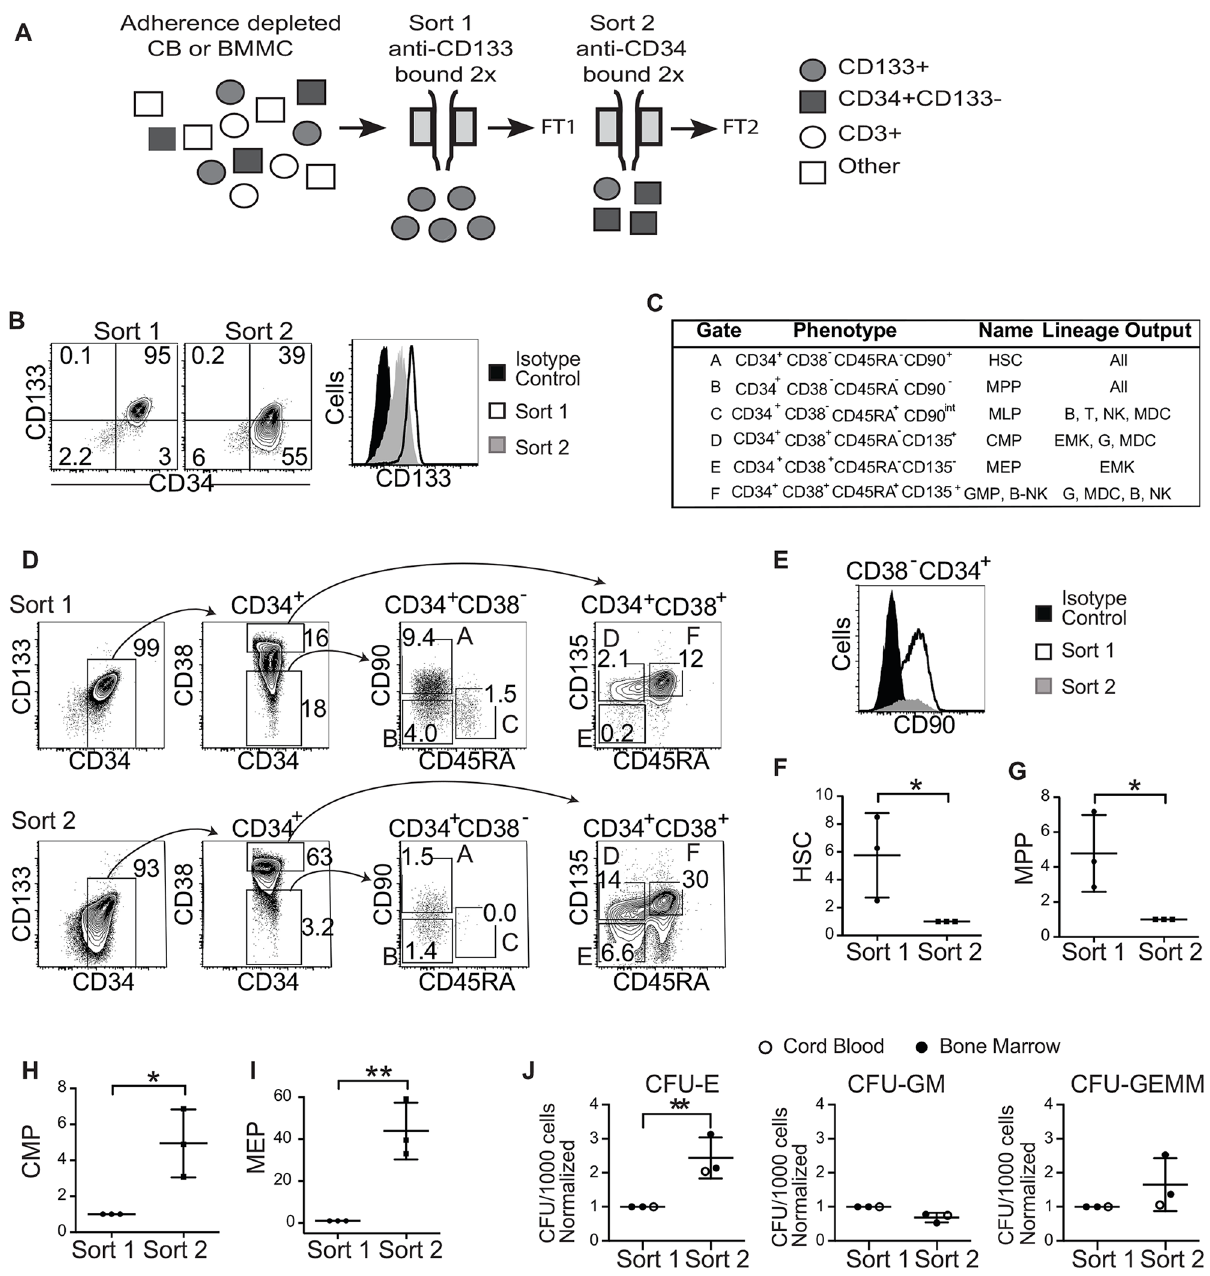
Fig 1. Sort 2 HSPCs are depleted for HSCs. A. Diagrammatic representation of HSPC purification.FT, column flow-through; CB, cord blood; BMMC, bonemarrow mononuclear cells. B. Representative flow cytometric analysisof HSPC samplesfrom an HIV + individual.C. Gates for each HSPC population phenotype and lineageoutput accordingto Doulatov et al [9]. (HSC, hematopoietic stem cell; MPP, multipotent progenitor; MLP, multilymphoid progenitor; CMP, common myeloidprogenitor; MEP, megakaryocyte/erythrocyte progenitor; GMP, granulocyte/monocyte progenitor; B-NK, B and NK cell progenitor; MDC, macrophage and dendriticcell; EMK, erythroid and megakaryocyte; G, granulocyte.) D. Representative flow cytometric analysisof differentiationmarkers expressedon bone marrow HSPCs purifiedas describedin A. For the two right-most panels,numbers indicate percentage of total CD34 + events from each sort falling into that gate. E. Flow cytometric plot comparingrelativenumbersof HSCs (CD34 + CD38 - cells that are also CD90 + ) in Sort 1 versus Sort 2. F-I. Summary graph showingthe relative frequency of the indicatedprogenitorin each sort, n = 3 uninfecteddonors. To facilitate comparison, results were normalized to Sort 2 (F and G) or Sort 1 (H—I). Mean ± standard deviationis indicated. J. Summary plots of methylcellulose colony formation assays from three uninfecteddonors. Mean ± standarddeviationis indicated.Colonyforming unit (CFU)-E, erythroid; CFU-GM, granulocyte/macrophage and CFU-GEMM, multilineage.( * p < 0.05and ** p < 0.01,2-tailedStudent’s t-test).